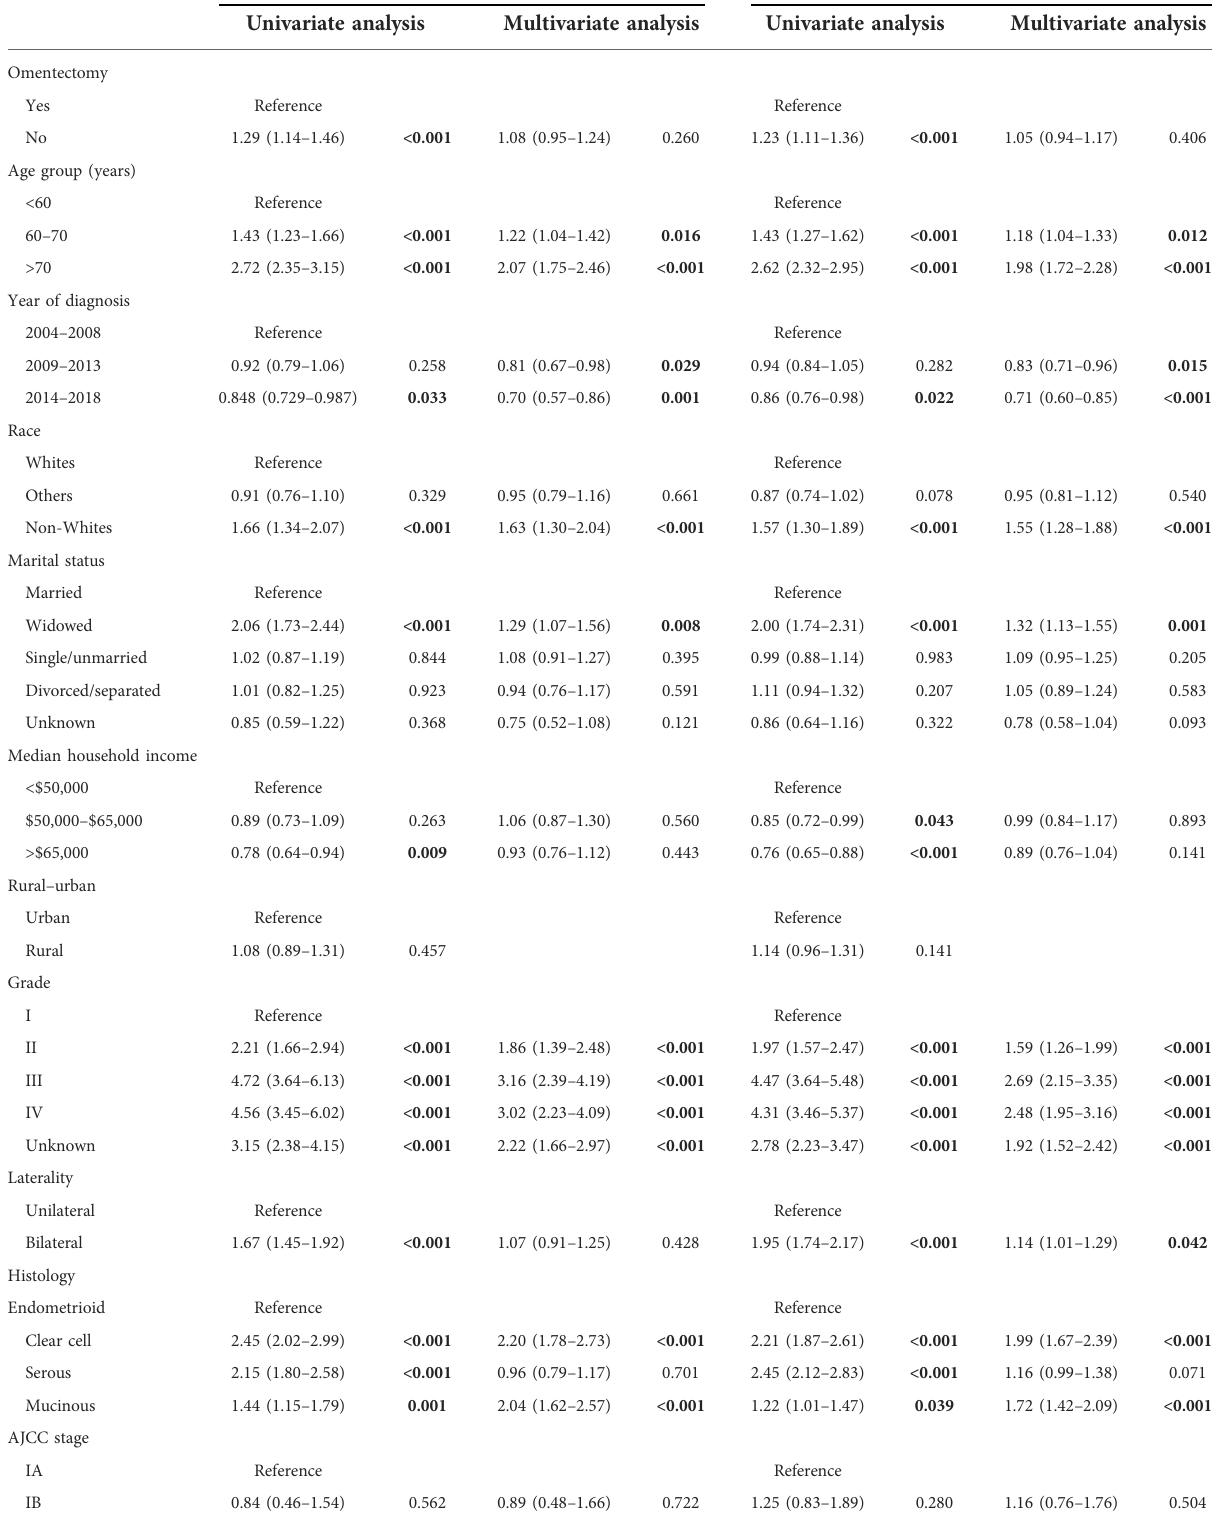
TABLE 3 Survival analysis of predicting CSS after IPTW adjusted by omentectomy in EOC